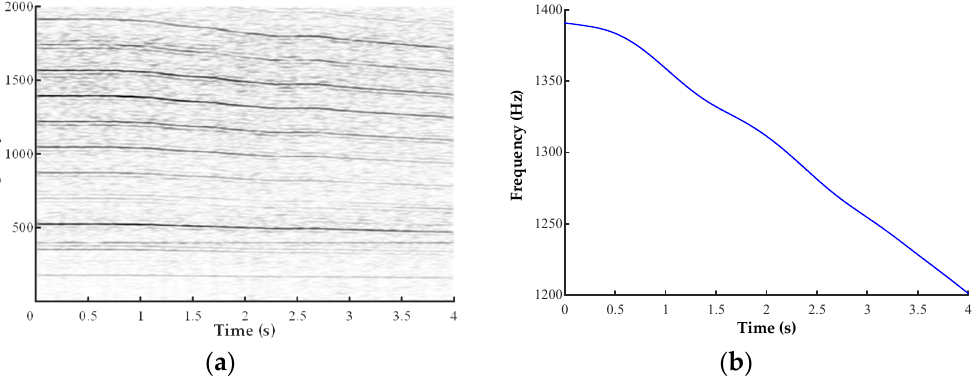
Figure 9. ( a ) Time-frequency diagram based on STFT; ( b ) Instantaneous frequency based on SCT and ACMP. In this paper, the instantaneous frequency of the k-order harmonic is obtained by obtaining the highest energy signal component, and then the angular domain vibration signal is obtained according to the order algorithm; see Figure 10a below. Through the order analysis of the obtained angular vibration signal, the order spectrum is obtained, as shown in Figure 10b. It can be seen from Figure 10b that the order distribution is clear and the frequency ambiguity caused by the speed change is solved. There are obvious peaks at the integral multiple of order 7 and order 7, and the sideband near the natural frequency is obvious, which is caused by local wear of the valve plate.